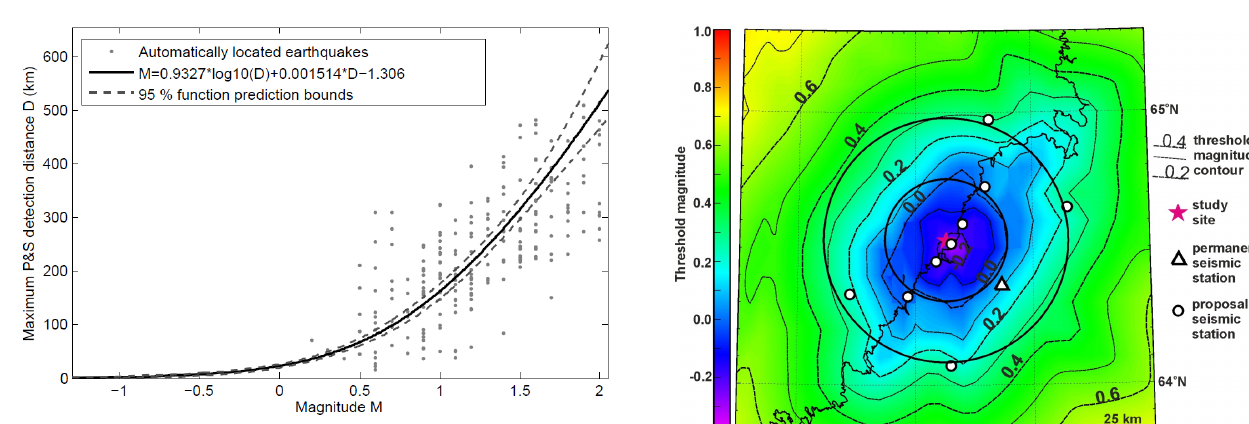
Figure 2. A calculated fit and the non-simultaneous 95 % function prediction bounds for the relationship between event magnitude and maximum P- and S-wave pair detection distance.